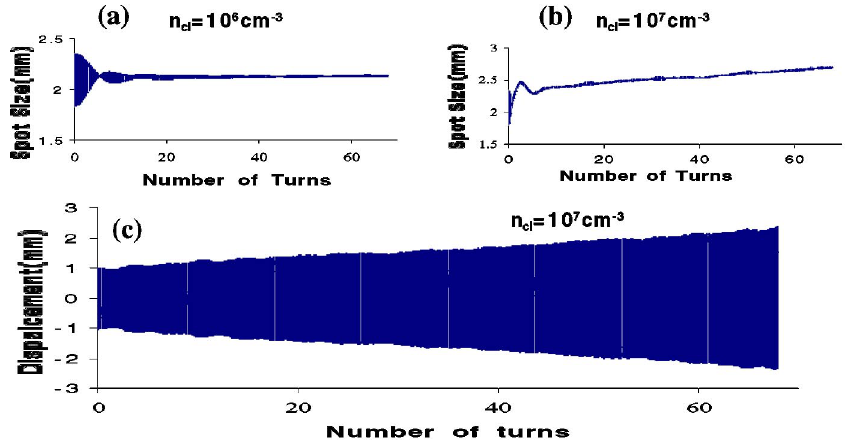
FIG. 9. (Color) QUICKPIC simulation of beam propagation over 70 turns of CERN-SPS (a) and (b) spot sizes for cloud densities 10 6 and 10 7 cm (cid:3) 3 , respectively. Some oscillation is observed initially in (a) that is because the beam is not matched initially. (c) Beam centroid in the vertical plane for 10 7 cm (cid:3) 3 of cloud